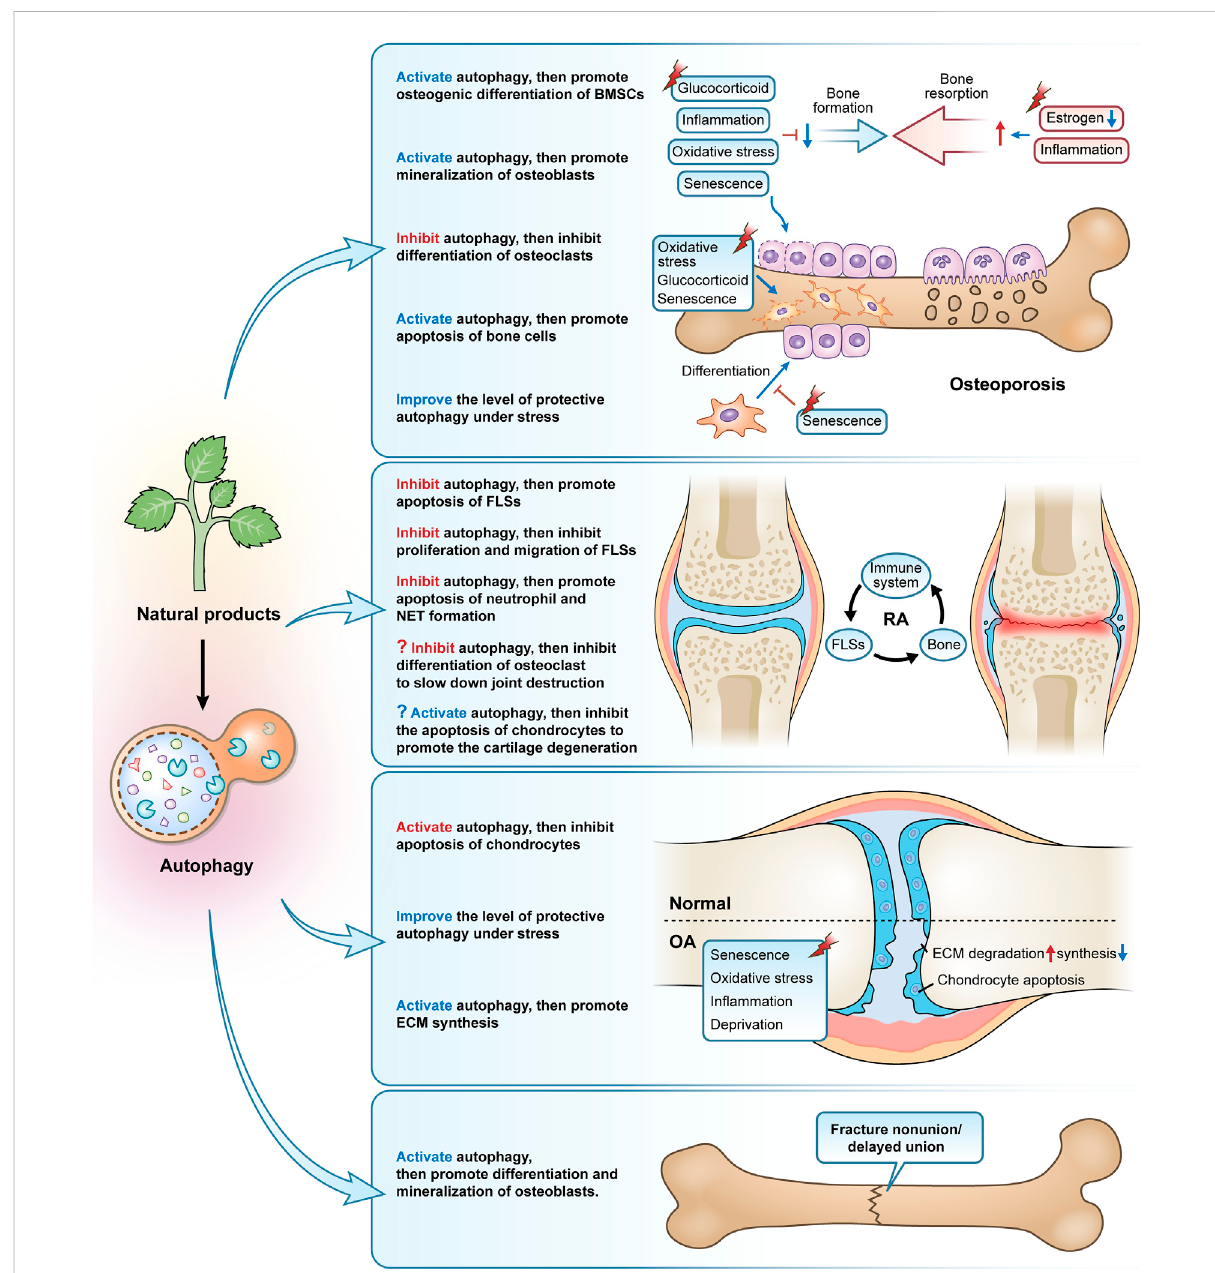
FIGURE 3 Theprimarymodesandmechanismsofnaturalproductstargetingautophagytoregulatebonemetabolismdisorders.Naturalproducts,usedas autophagy activators or inhibitors, can effectively control osteoporosis, rheumatoid arthritis, osteoarthritis, and fracture nonunion/delayed